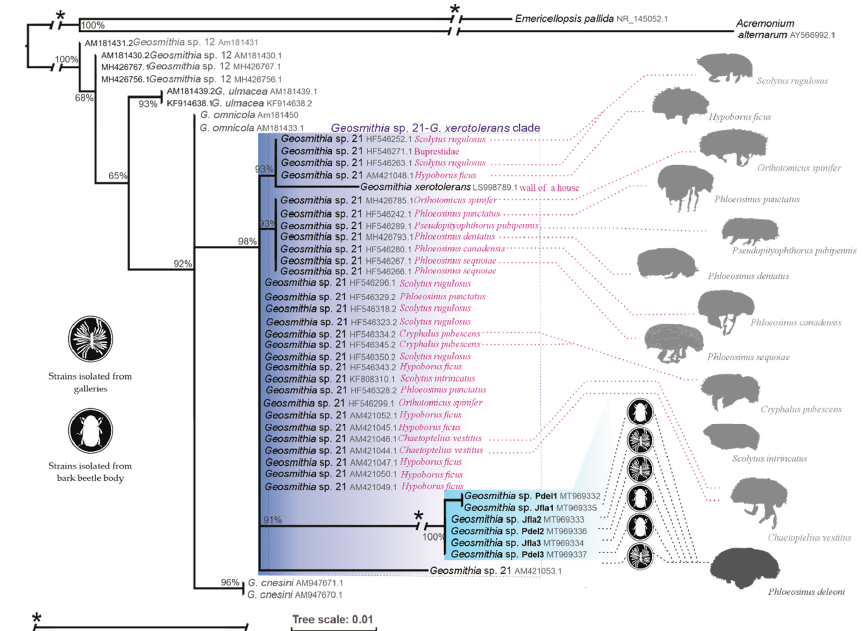
Figure 5. Phylogenetic relationships within of strains from Geosmithia sp. 21- G. xerotolerans clade from Galeana, Nuevo León and its most closely related species based on the ITS sequences. The phylogenetic tree was obtained by Maximum Likelihood from 49 Geosmithia sequences. Emericellopsis pallida and Acremonium alternarum were selected as outgroups. Acronyms Pdel and Jfla corresponding to strains isolated from Phloeosinus deleoni and Juniperus flaccida , respectively. The asterisks on the tree indicate the sections of the branches that were cut out, for representational purposes. The straight line with the asterisk under the tree indicates the length of the section that was cut, which was the same in all cases.